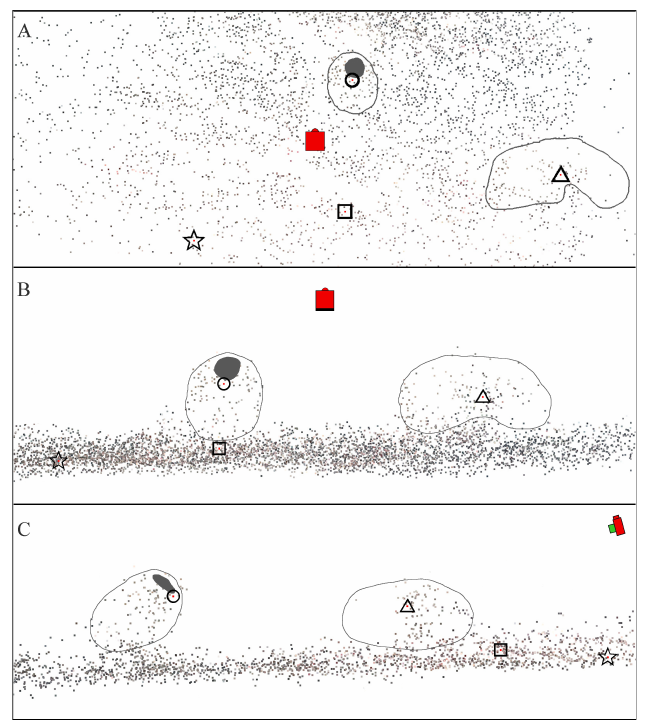
Fig. 4. 3-D SmartPoints cloud: the sponges visible in Figs. 2 and 3 are outlined. The same points are marked as in Fig. 3 and the relative orientation of the camera position A1 is shown in red. (A) View from the same angle as from camera position A1. (B) View from the same direction as camera position A1 but at bottom level. (C) View from the left side of camera position A1 at bottom